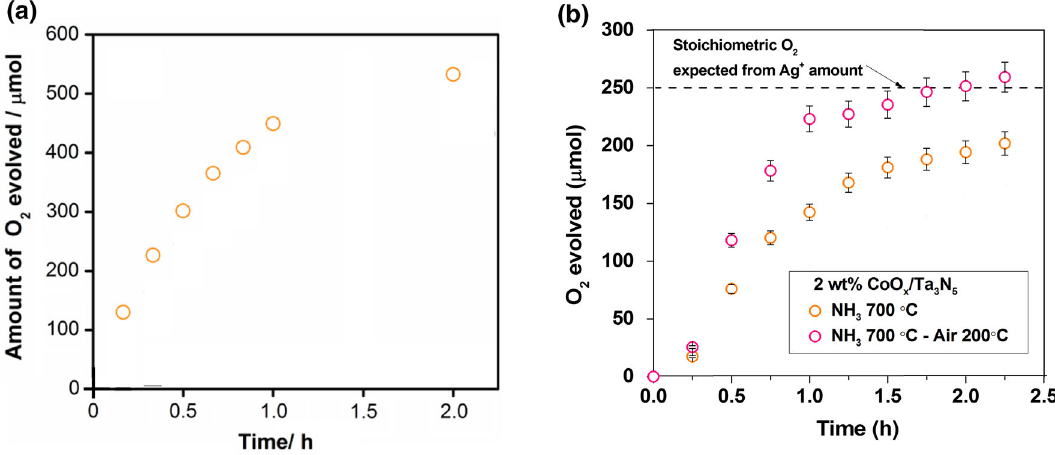
Fig. 8 Time course of photocatalytic OER on a 2 wt % CoO x / Na 2 CO 3 -Ta 3 N 5 nitrided at 500 (cid:3) C for 1 h, adapted with permission from [42] Copyright (2012) American Chemical Society, and b on nitrided 2 wt % CoO x /Ta 3 N 5 with and without oxidation at 200 (cid:3) C for